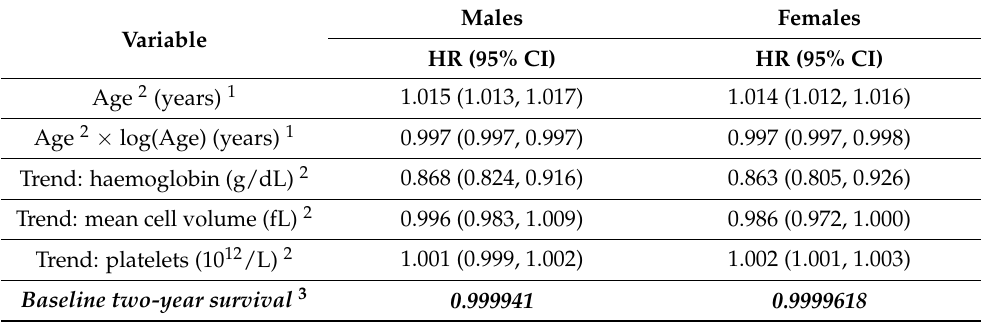
Table 2. Cox sub-model from the joint